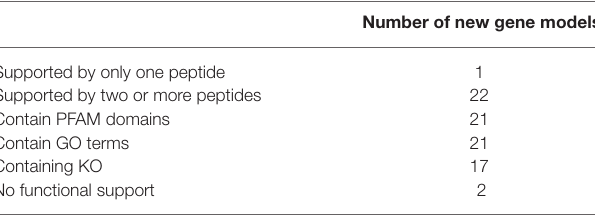
TABLE 7 | Summary of new gene validation using supporting peptides, Protein Families, and Gene Ontology terms.